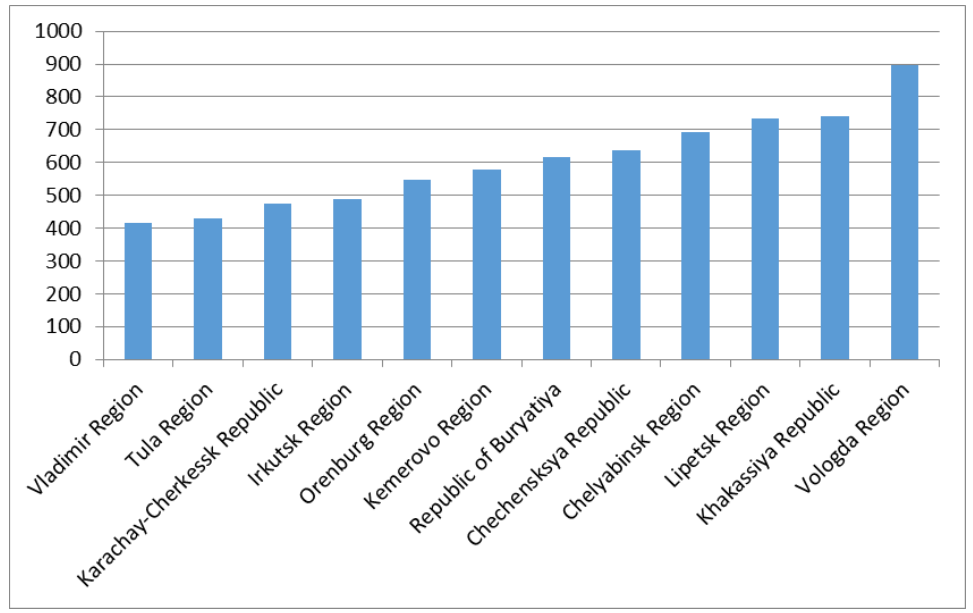
Figure 5: Number of regions with energy intensity of given range (kg of fuel equivalent per 10 thousand rubles in 2010)